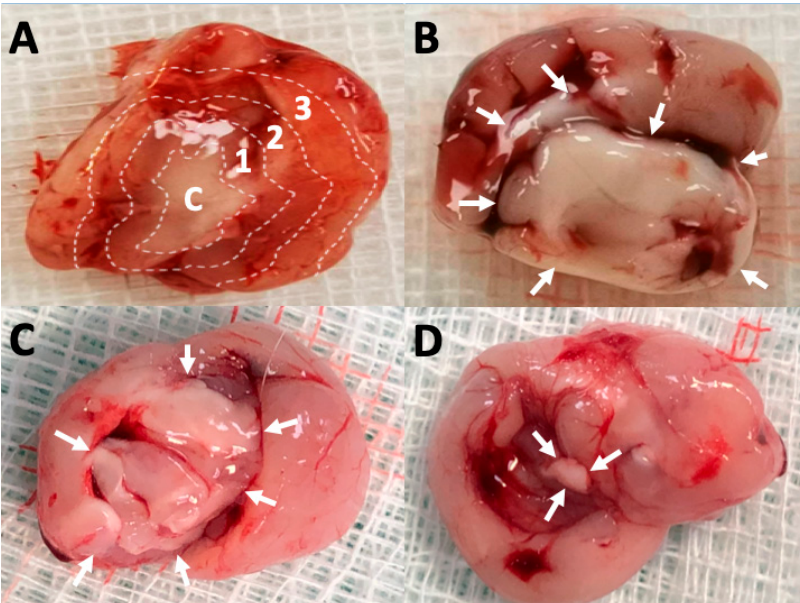
Figure 1. Degradation of VMPs. ( A ) Injected vancomycin-embedded poly(lactide- co -glycolide acid) microparticles (VMPs) resulted in a white core, and the brain parenchyma was divided to zones 1–3 (each zone thickness ~2–3 mm) for tissue sampling. C: core, 1: zone 1, 2: zone 2, and 3: zone 3. Overall appearance (B ) 1 week, ( C ) 4 weeks, and ( D ) 8 weeks after VMP injection into the brain parenchyma. Injected VMPs were denser and greater (indicated by white arrows) during the first few weeks and degraded with time.